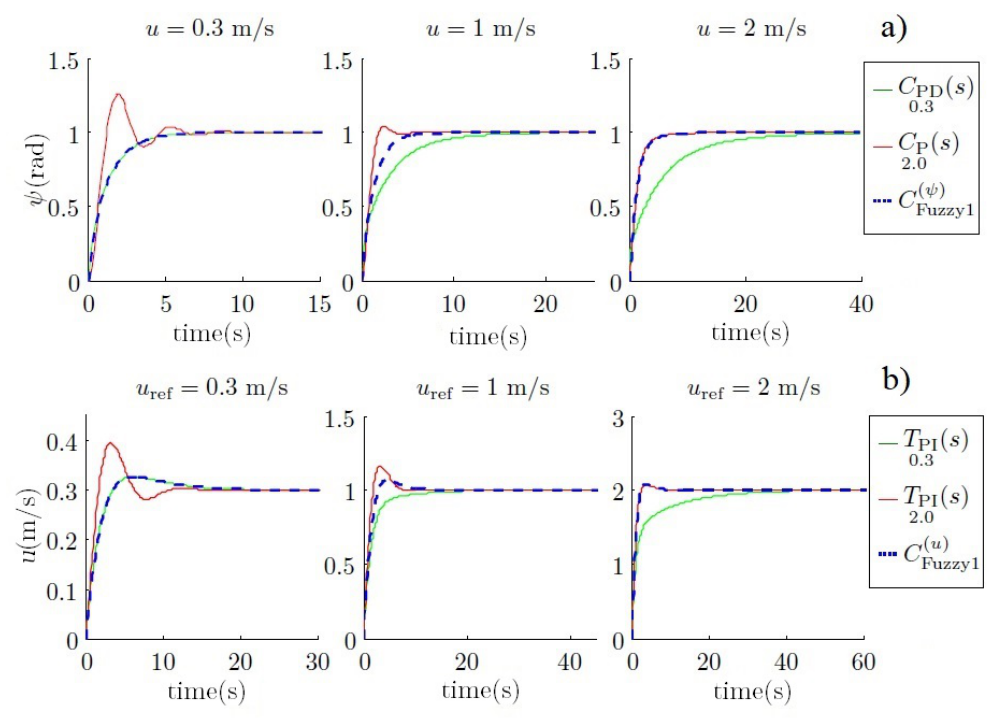
Figure 14. Comparison of the step response for the yaw ( a ) and forward velocity ( b ) using the fuzzy controller (discontinuous blue line) and linear controllers (green and red lines). The time scales are different for a better response appreciation between controllers at different